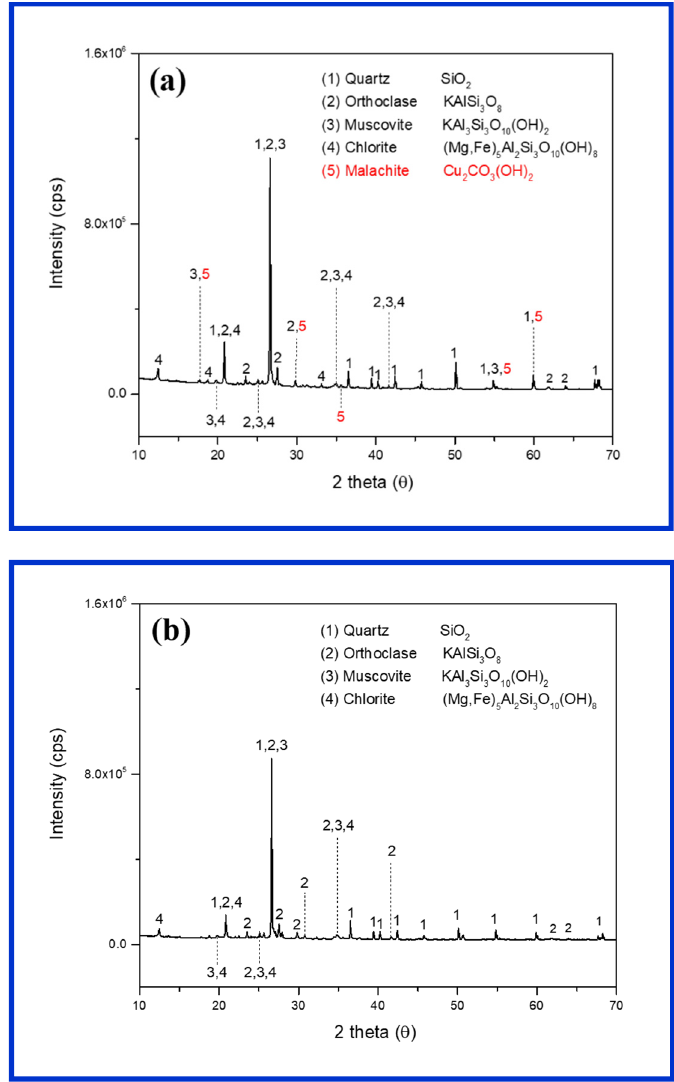
Figure 2. X-ray diffraction studies of ore samples before leaching ( a ) and after a weeklong (7 days) leaching with H 2 SO 4 (0.15 M) ( b ).